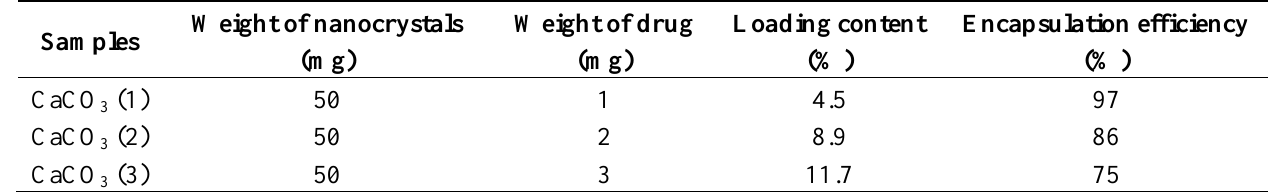
Table 1. Drug loading concentrations, loading content and encapsulation efficiency.